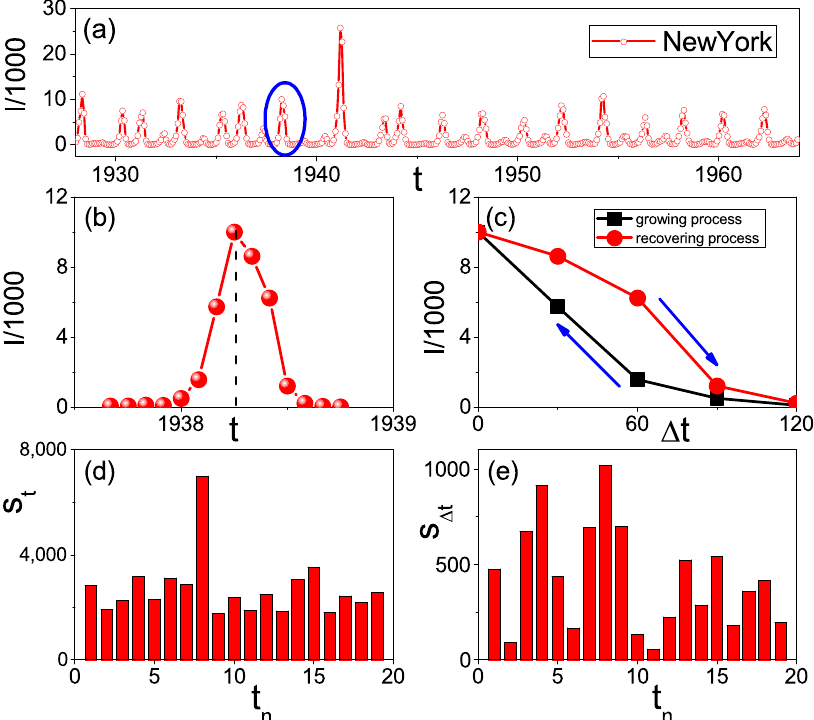
Figure 1. A typical real data of recurrent epidemics and its features. ( a ) Represents the time series of reported measles infective cases I in New York, where the variable I is from 0 to 3 × 10 4 41 . ( b ) Amplification of the outbreak marked in the blue circle of ( a ). ( c ) The hysteresis loop of ( b ) in the rescaled framework where the original point is taken as the time pointed by the dashed line in ( b ) and the “squares” and “circles” denote the growing and recovering phases, respectively. ( d ) The area S t of each outbreak in ( a ) where t n is the number of outbreaks. ( e ) The area S Δ t of hysteresis loops for the successive outbreaks in ( a